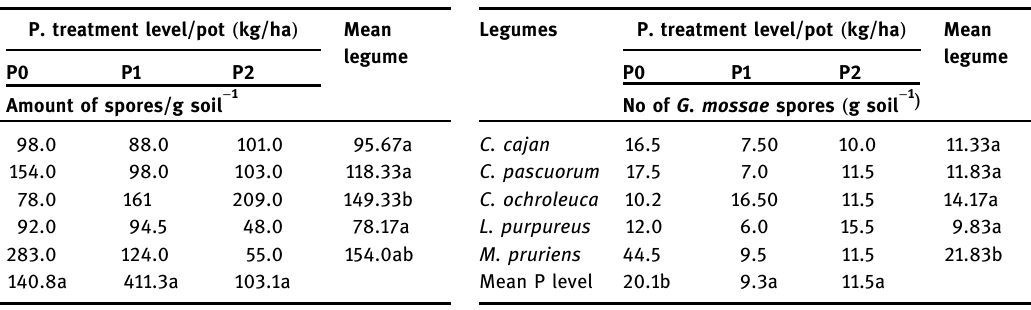
Table 3: E ff ect of phosphorus levels and studied legume species on spores of G.